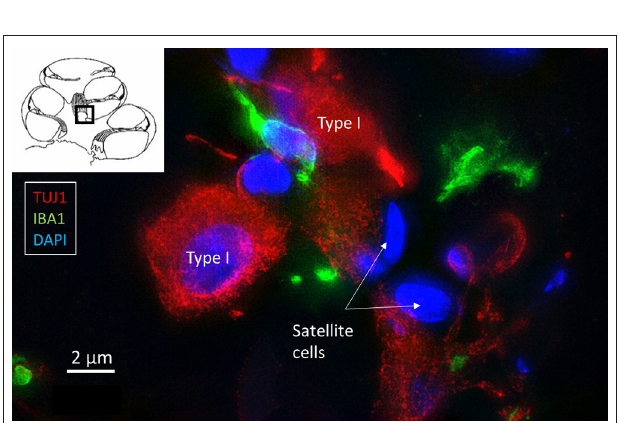
FIGURE 7 | SR-SIM of IBA1 cells (green) contacting type I spiral ganglion cells (red).